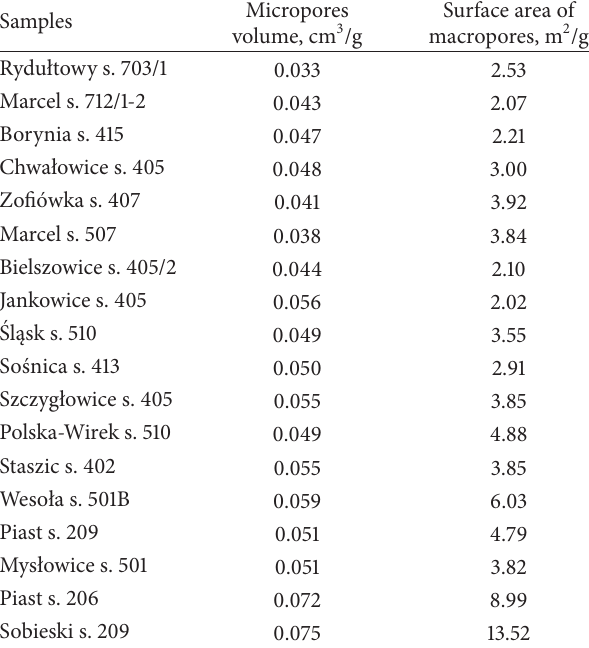
Table 3: The values of micropores volume and surface area of macropores for individual coal samples.